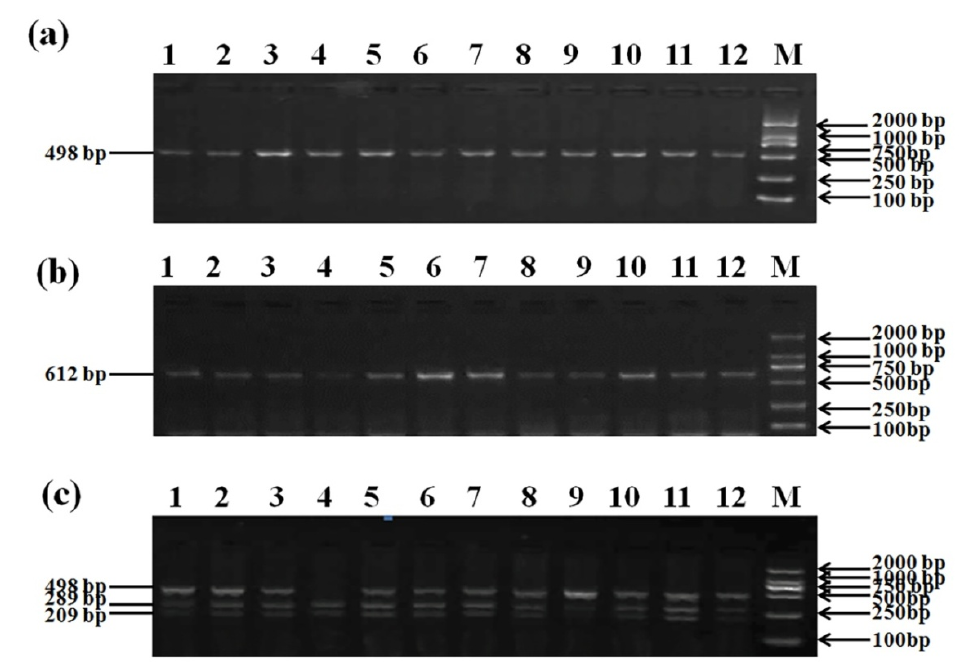
Figure 4. Agarose gel electrophoresis (1.5%) of PCR-amplified products in GHRHR gene. ( a ) F1R1 primer, ( b ) F2R2 primer, and ( c ) PCR- PshAI -RFLP result of SNP1 at g.2052C > G, genotype GG (498 bp), genotype GC (498 + 289 + 209 bp), and genotype CC (209 bp). Lanes 1 to 12 show the products and Lane M presents 2000 bp DNA ladder.